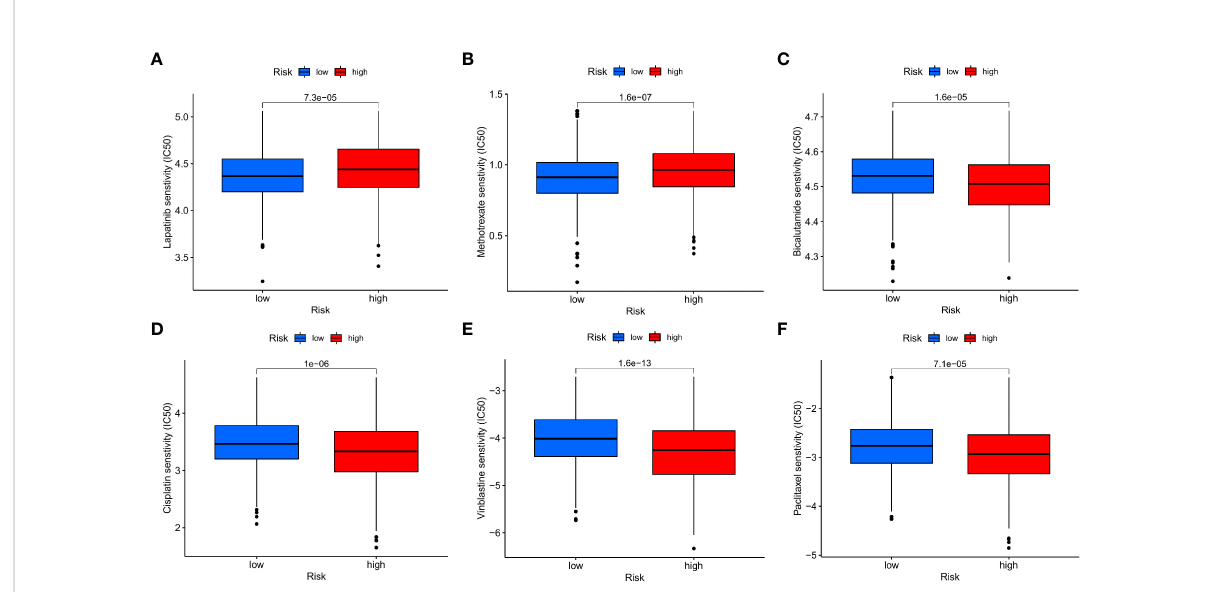
FIGURE 11 The IMRG risk score and drug sensitivity. (A) Lapatinib; (B) Methotrexate; (C) Bicalutamide; (D) Cisplatin; (E) Vinblastine; (F)